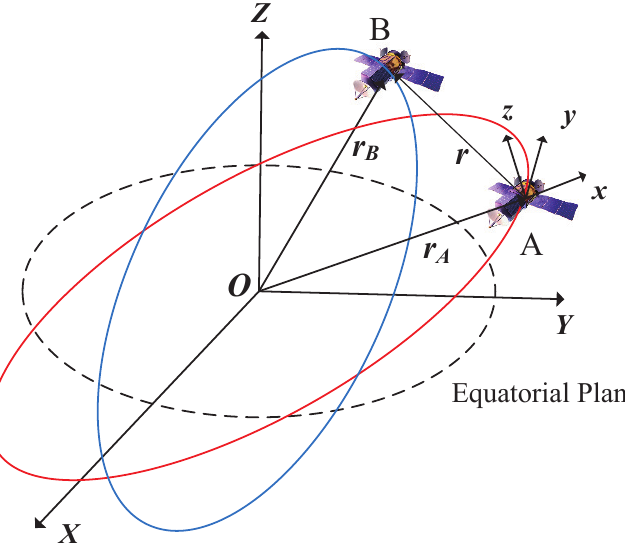
Figure 1. Spacecraft relative motion coordinate